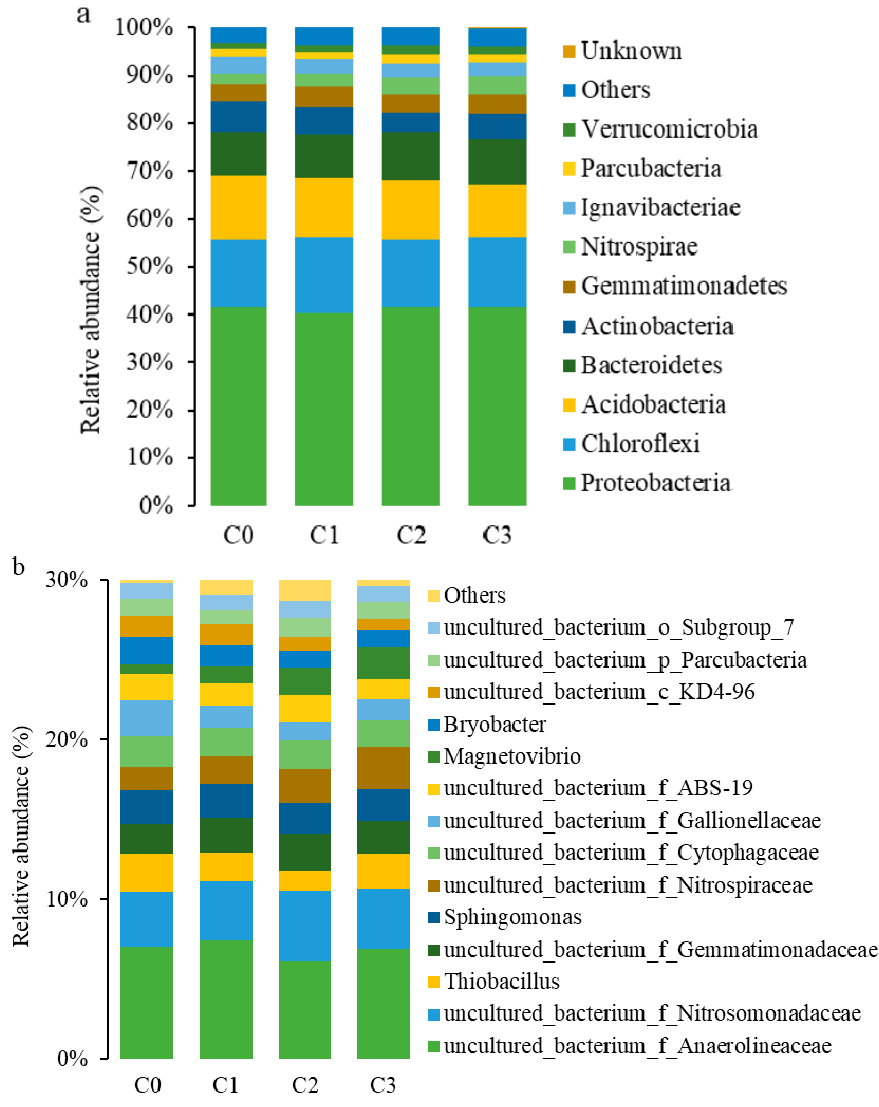
Figure 2. Relative abundance of dominant microbial taxa at phylum ( a ) and genus ( b ) level in different biochar addition rate.